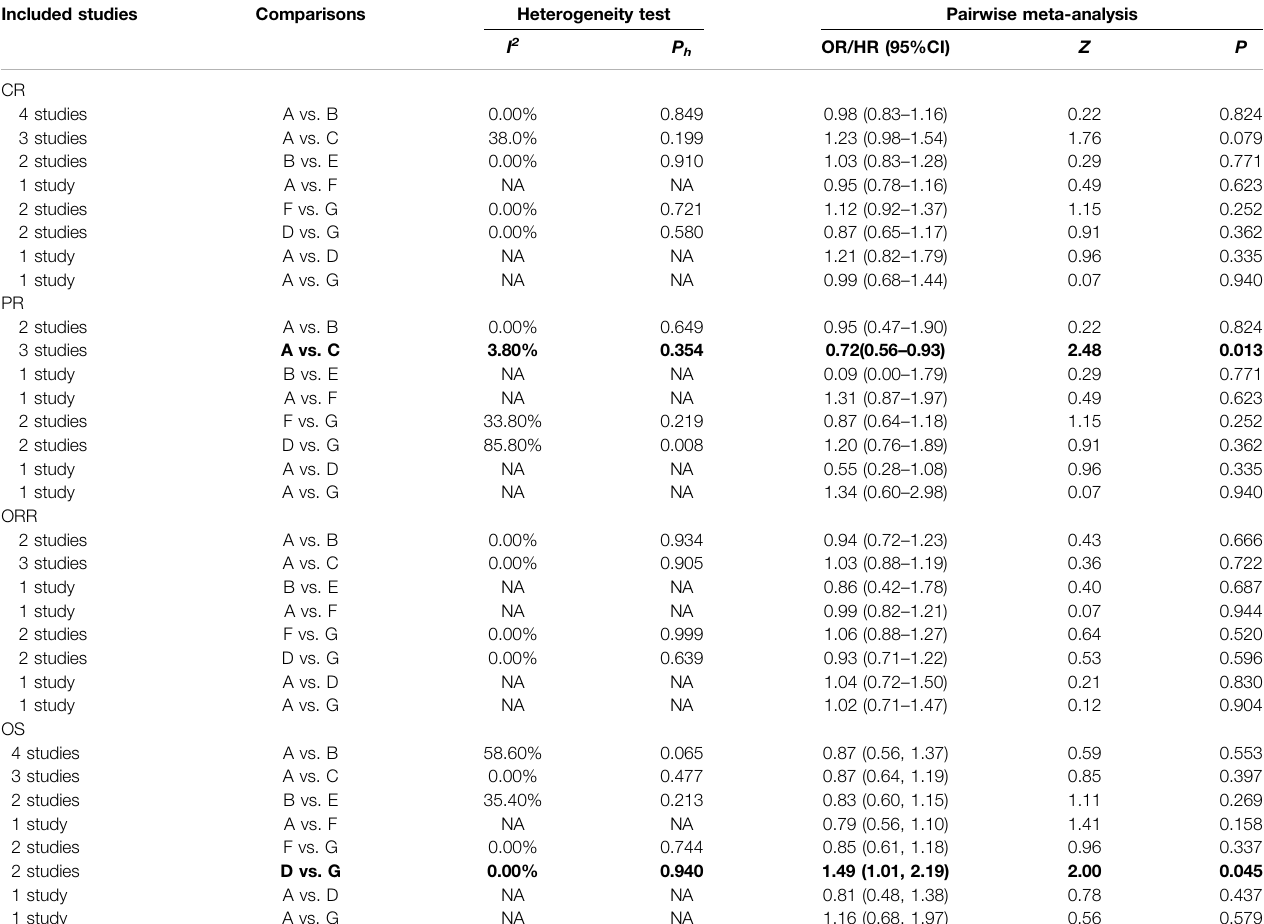
TABLE 1 | Estimated OR and 95%CI of pairwise meta-analysis for ef fi cacy in Hodgkin